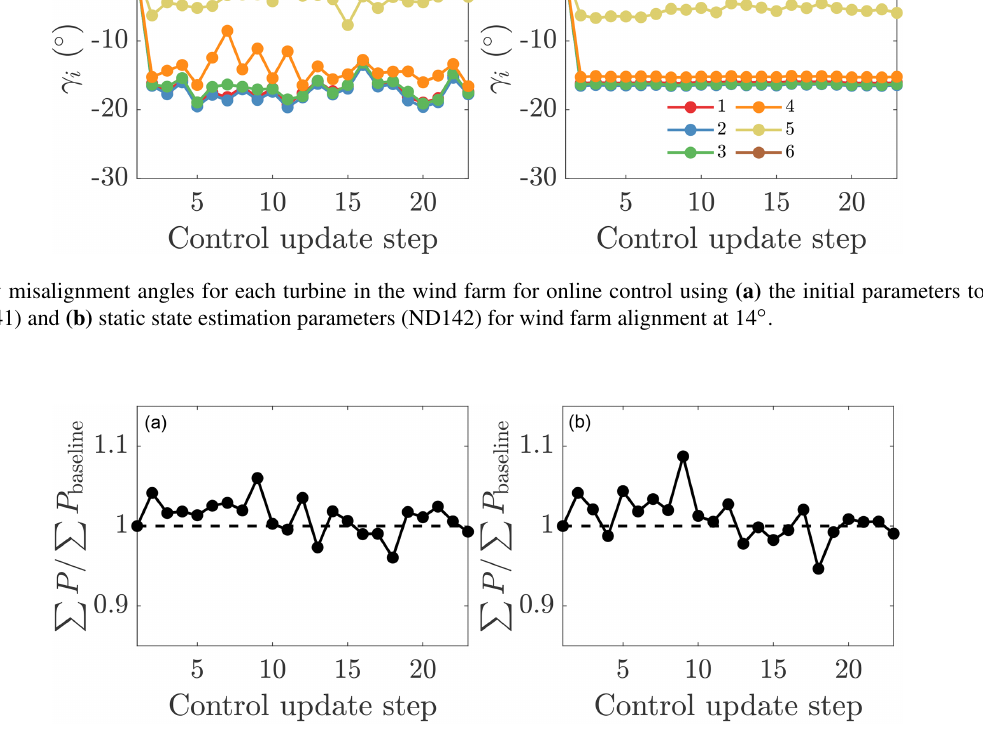
Figure E2. Time-averaged wind farm power production as a function of the control update step for online control using (a) the initial parameters to initialize the next state (ND141) and (b) static state estimation parameters for wind farm alignment at 14 ◦ (ND142). The wind farm power is normalized by the power production of the aligned wind farm